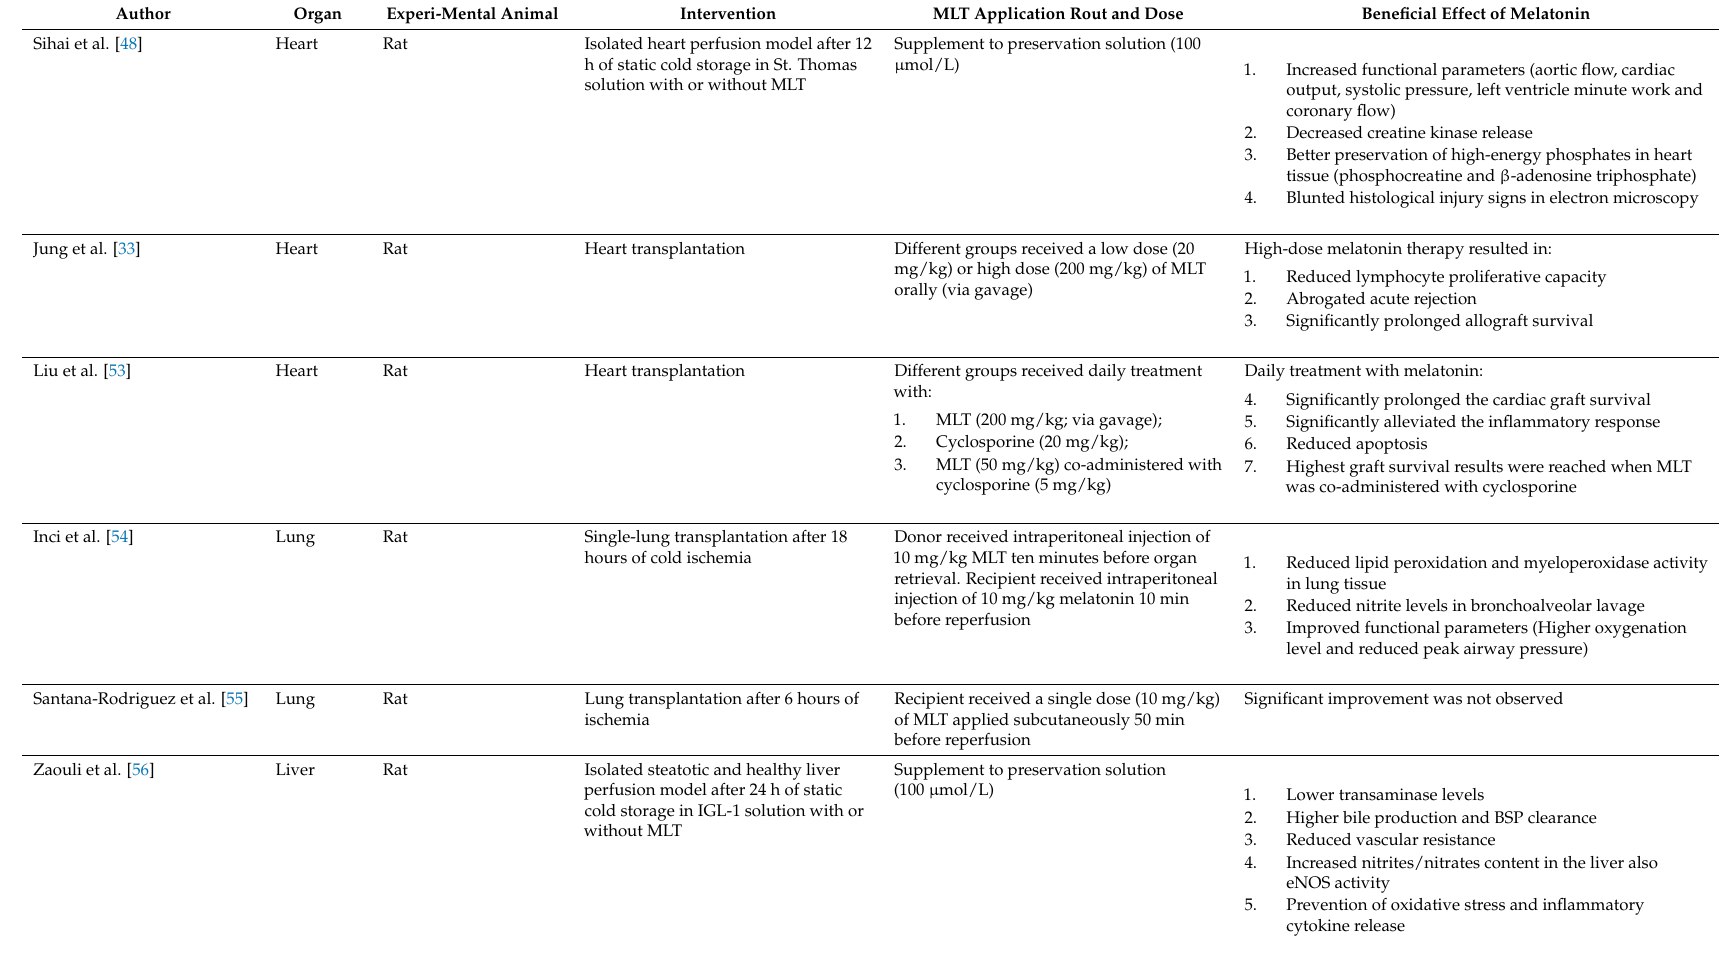
Table 1. Melatonin application in experimental transplantation